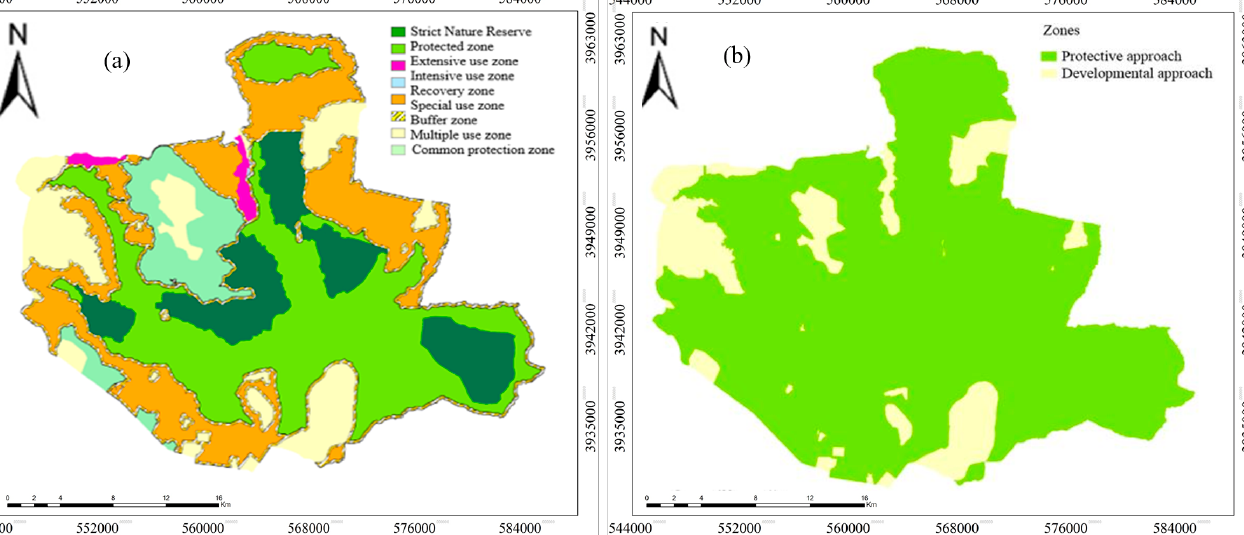
Table 9. Socio-demographic profile of the respondents participating in the Delphi study component to assess indicators affected by ecological risk in two Protected Areas in the Tehran province, Iran.